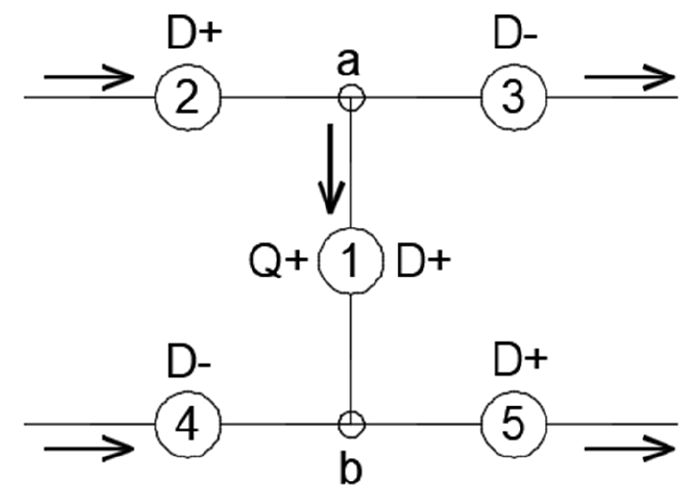
Figure 4. Different options for the increase in the flow velocity in a pipe.